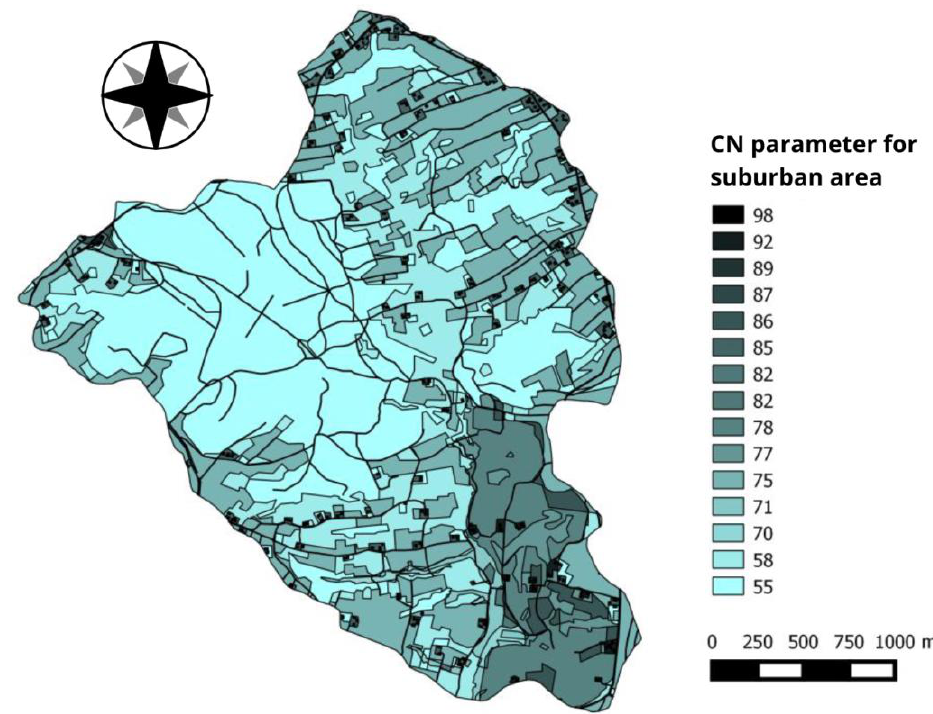
Figure 3. Curve number for urban area.